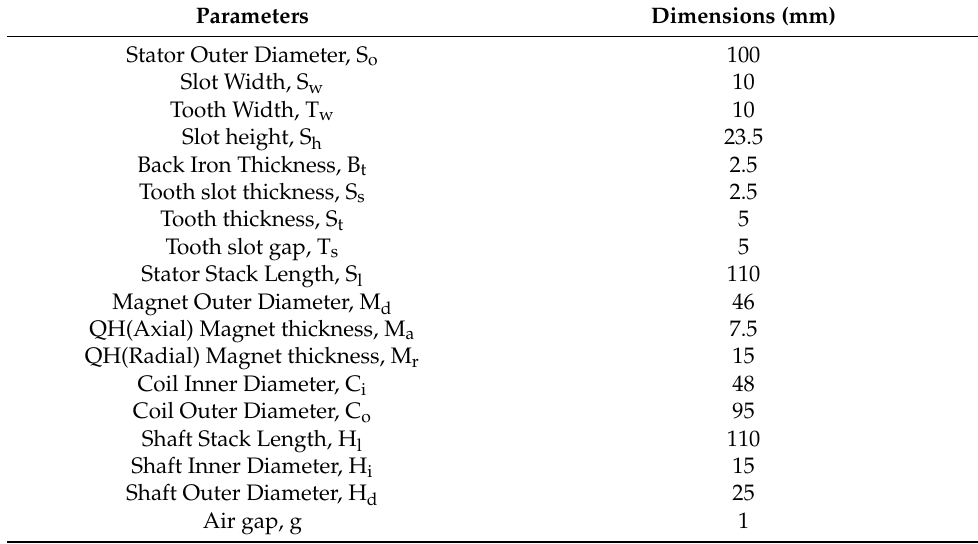
Table 1. Geometrical parameters of the original PMLA.